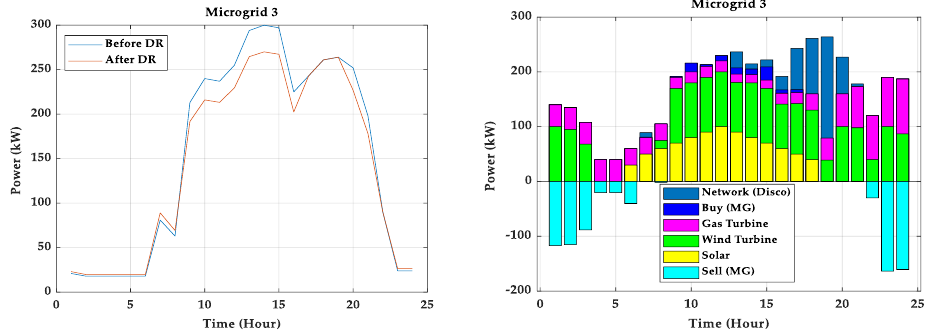
Figure 24. Impact of DR and power-sharing on MG 3.